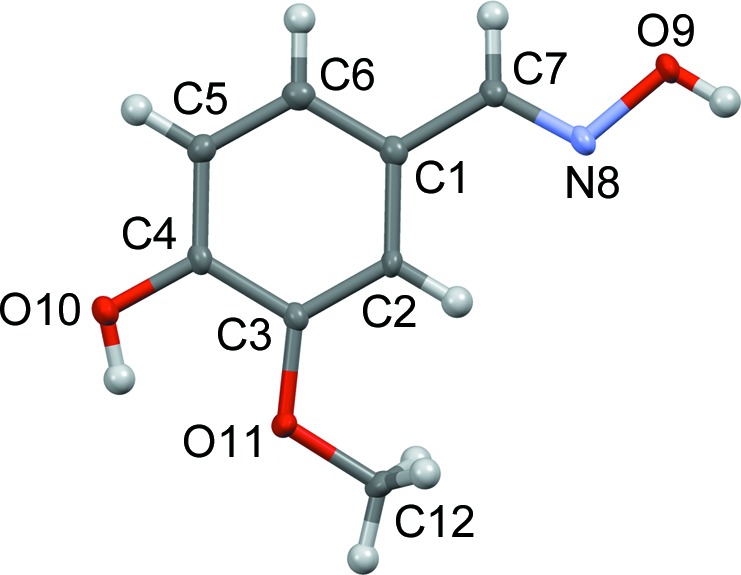
The atom-labelling scheme for 1
 according to Jerslev & Larsen (1991 ▸). The a molecule of the LT phase is shown, with ellipsoids drawn at the 50% probability level, except for H atoms which are represented as spheres of arbitrary radii. Colour code: C grey, N blue, O red and H white.